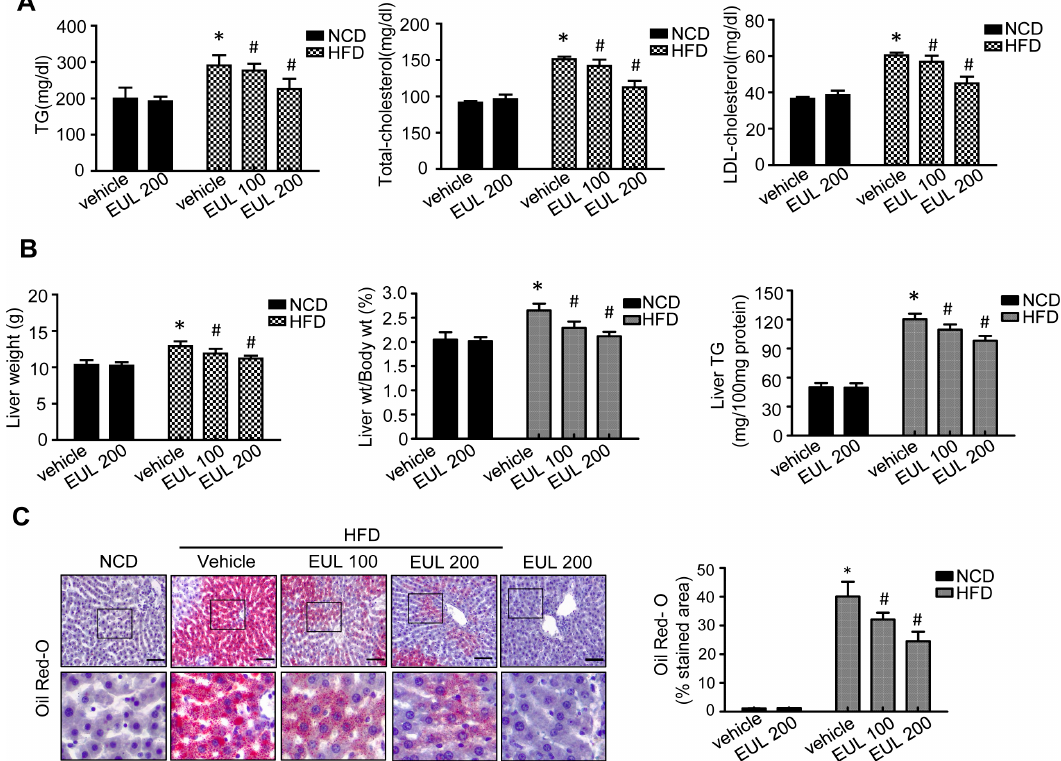
Figure 2. EUL prevents HFD-induced hepatic steatosis. Rats were fed a NCD or a HFD with or without administration of 100 mg/kg or 200 mg/kg EUL for 6 weeks, and sera and livers were harvested. ( A ). Biochemical analyses of serum samples. Serum levels of TG, TC, and LDL cholesterol in the experimental groups. ( B ) Liver weight, liver weight/body weight, and liver TG contents were measured 6 weeks after initial EUL administration ( n = 6). ( C ) Liver tissues retrieved 6 weeks after initial EUL administration that were subjected to Oil red O staining. Scale bars, 200 µ m. Values are means ± SDs. ( n = 6, * p < 0.05 versus NCD group, # p < 0.05 versus HFD group). NCD, normal chow diet; HFD, high-fat diet; EUL, Eucommia ulmoides leaf extract; TG, triglyceride; LDL, low-density lipoprotein.